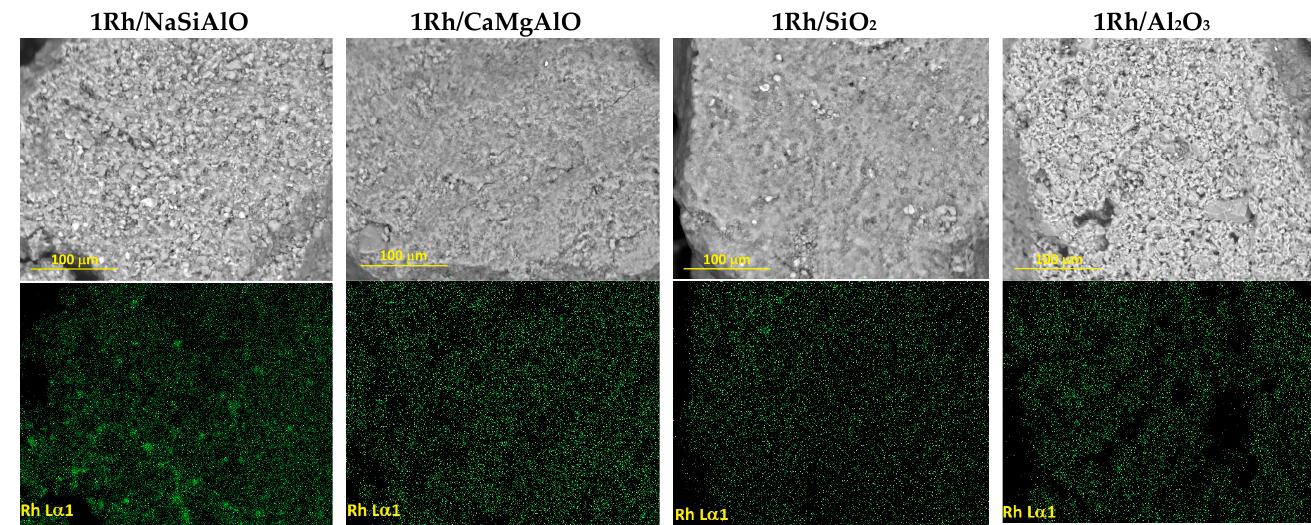
Figure 3. SEM images (the upper row) and rhodium distribution maps (the lower row) of the rhodium-containing catalysts.